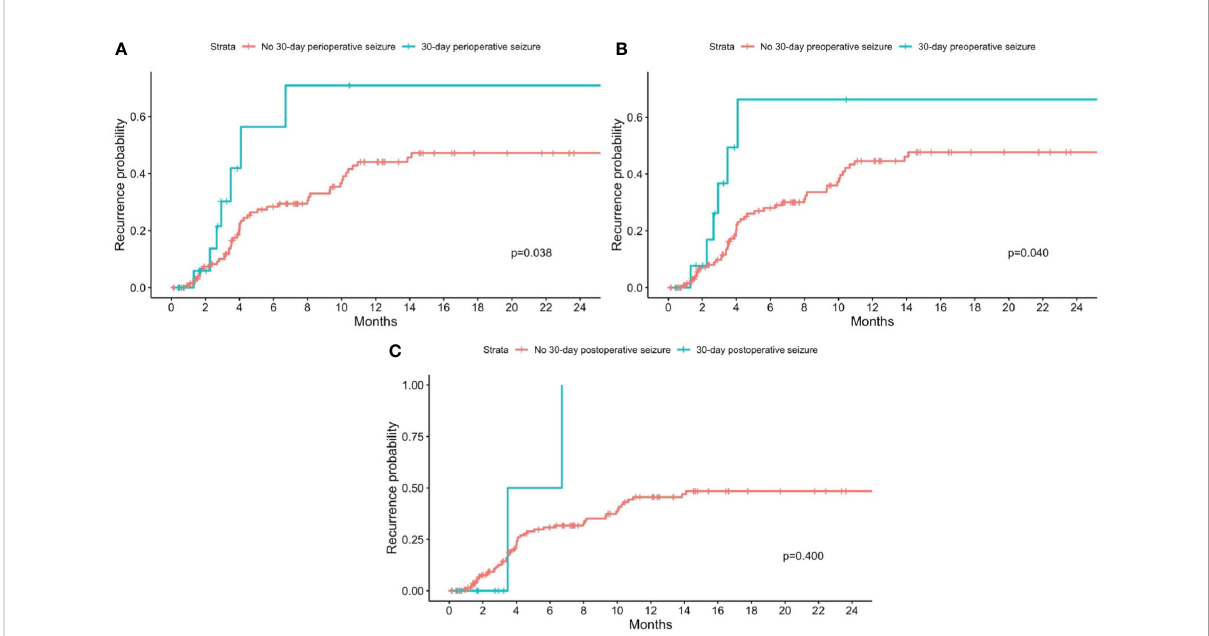
FIGURE 2 Kaplan-Meier curves for recurrence strati fi ed by patients with and without 30-day perioperative seizures. Patients with no 30-day perioperative seizures are shown in red, while patients with (A) any 30-day perioperative seizure; (B) 30-day preoperative seizure; and (C) 30-day postoperative seizure are shown in blue. P-values from the log-rank test are shown in each fi gure